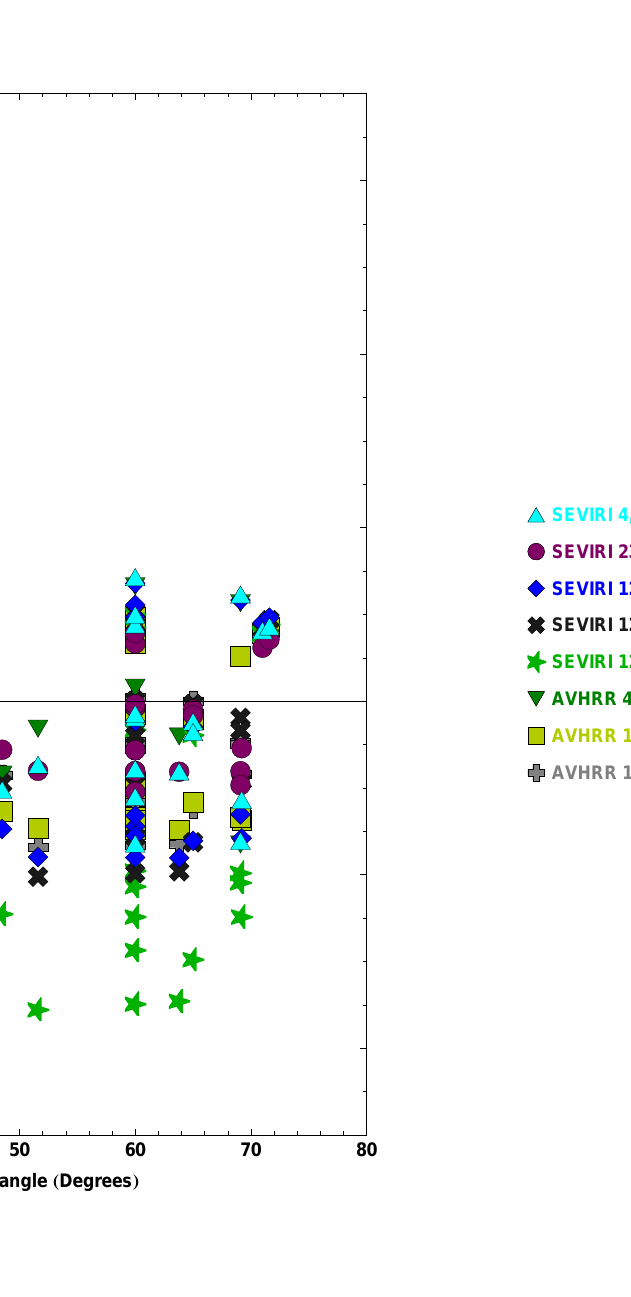
Figure 9. The relative difference between two broadband albedo estimates and the sun zenith angle for various targets. We derived the two albedo values as follows: (1) by using various broadband conversion formulae from van Leeuwen and Roujean [26] and (2) by directly integrating the measured BRF